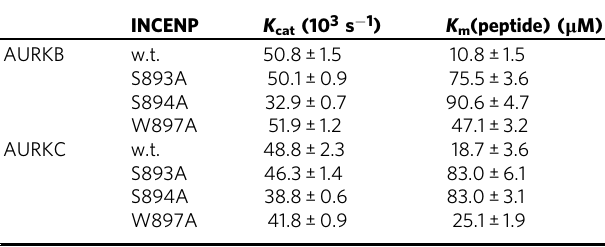
Note : The data shown are the best- fi t values±standard S893A/S894A/W897A showed a larger change (Fig. 3g) consistent with a model in which binding of the phosphorylated TSS motif serine residues and Trp897 provide additional stability to the AURKC:INCENP complex.